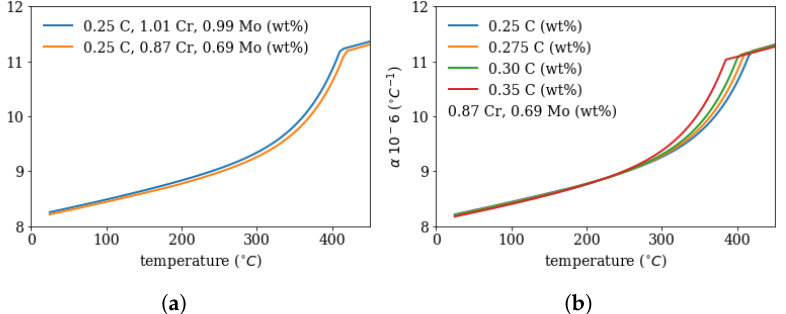
Figure 6. Calculated thermal expansion coefficient α (with JMatPro) as function of temperature for different ( a ) Cr and Mo content for the depleted region I (0.87%Cr, 0.69%Mo) and for the segregated region II (1.01%Cr, 0.99%Mo) and ( b ) carbon content in the depleted